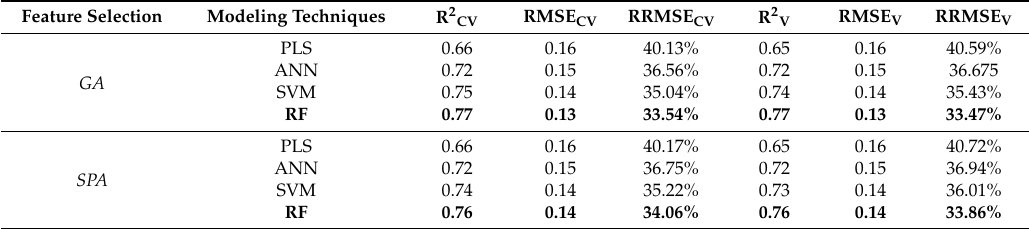
Table 1. Model performance of cross validation (CV) and independent validation (V) for microplankton size fractions obtained by different combinations of feature selection and modelling techniques. Feature selection techniques included genetic algorithm (GA), successive projection algorithm (SPA), and recursive feature elimination based on support vector machine regression (SVM-RFE). And, the modeling techniques included partial least square (PLS) regression, artificial neural network (ANN), support vector machine (SVM), and random forests